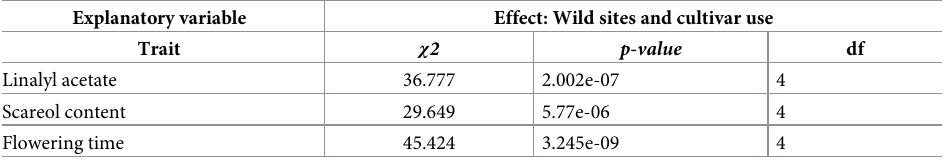
Table 2. Summary of the effect of the site of origin of the wild populations and the use for cultivation of the culti- vated clary sage on phenotypic trait variation (Model 1) in Salvia sclarea